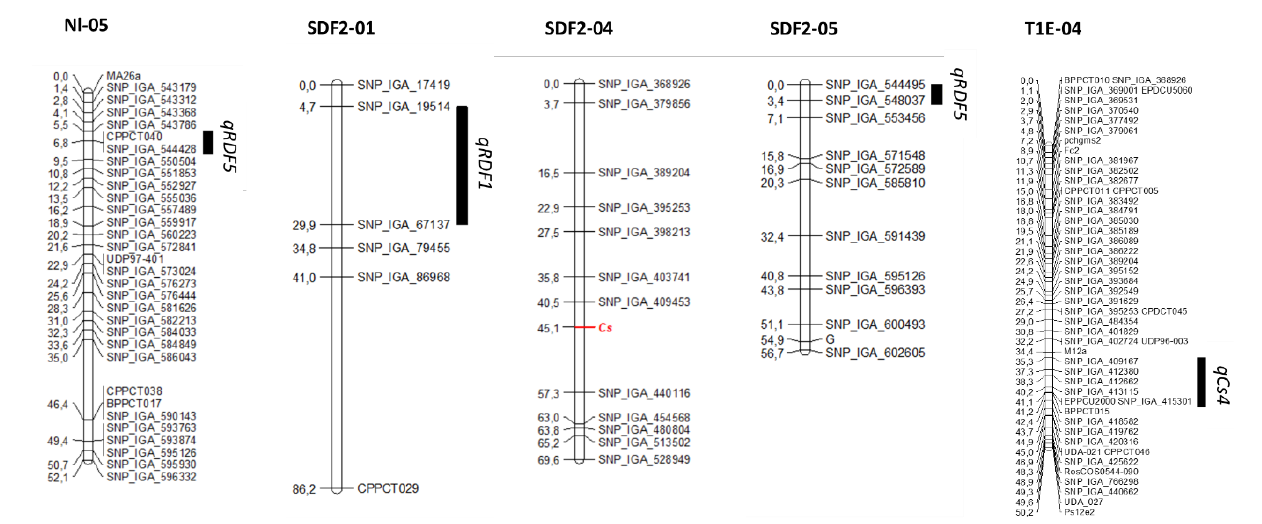
Figure 3. Genetic maps and QTLs from Nectalady (Nl) map of the BtxNl population, and SDF2 and T1E maps. Cs is indicated in red. Black bars indicate the LOD-1 interval.